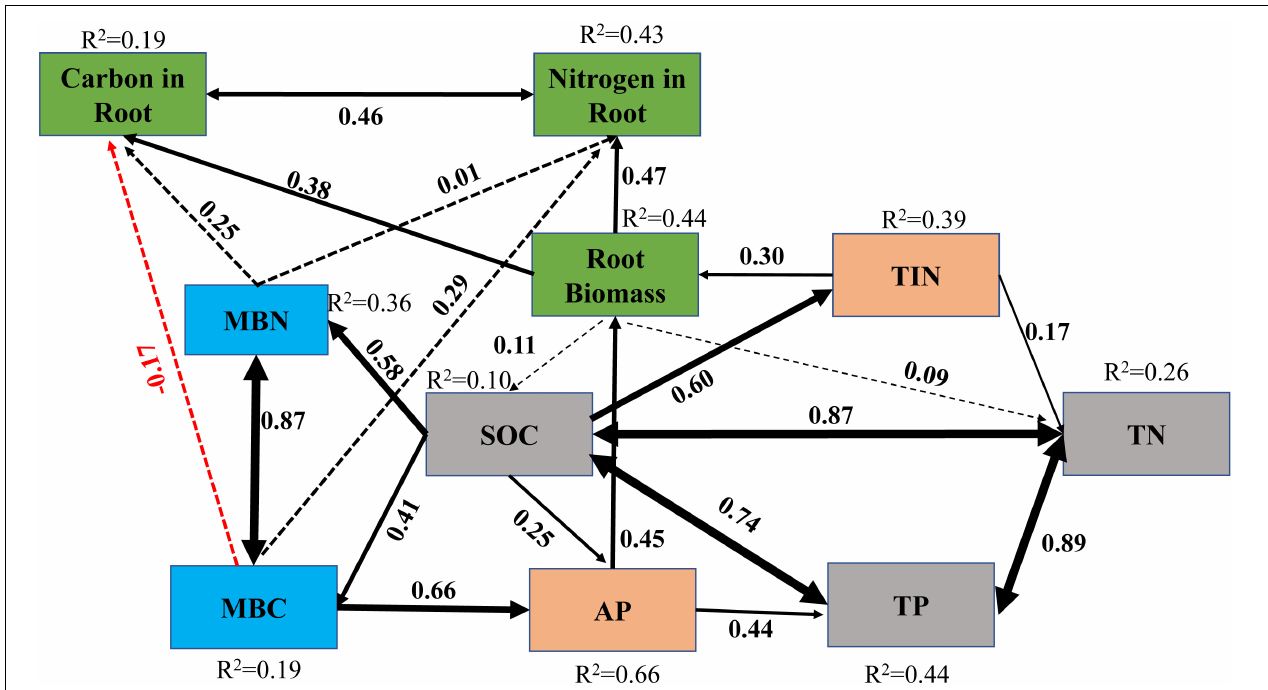
FIGURE 5 | Structural equation model (SEM) showing the relationship between soil total nutrients, mineralized nutrients, microbial composition, and root characteristics (Df = 23, NFI = 0.952, CFI = 0.999, RMSEA = 0.022, p = 0.427). All variables are observed variables. Solid and dashed lines represent significant and non-significant pathways, respectively. Single-headed arrows represent the direction of causality and double-headed arrows indicate correlations between variables. The numbers adjacent to the arrows are standardized path coefficients. The proportion of variance explained ( R 2 ) is shown alongside each response variable (data were collected in 2019, 17 years after revegetation). TIN, total inorganic nitrogen; MBC, microbial biomass carbon; MBN, microbial biomass nitrogen; SOC, soil organic carbon; TN, total nitrogen; TP, total phosphorus; AP, available